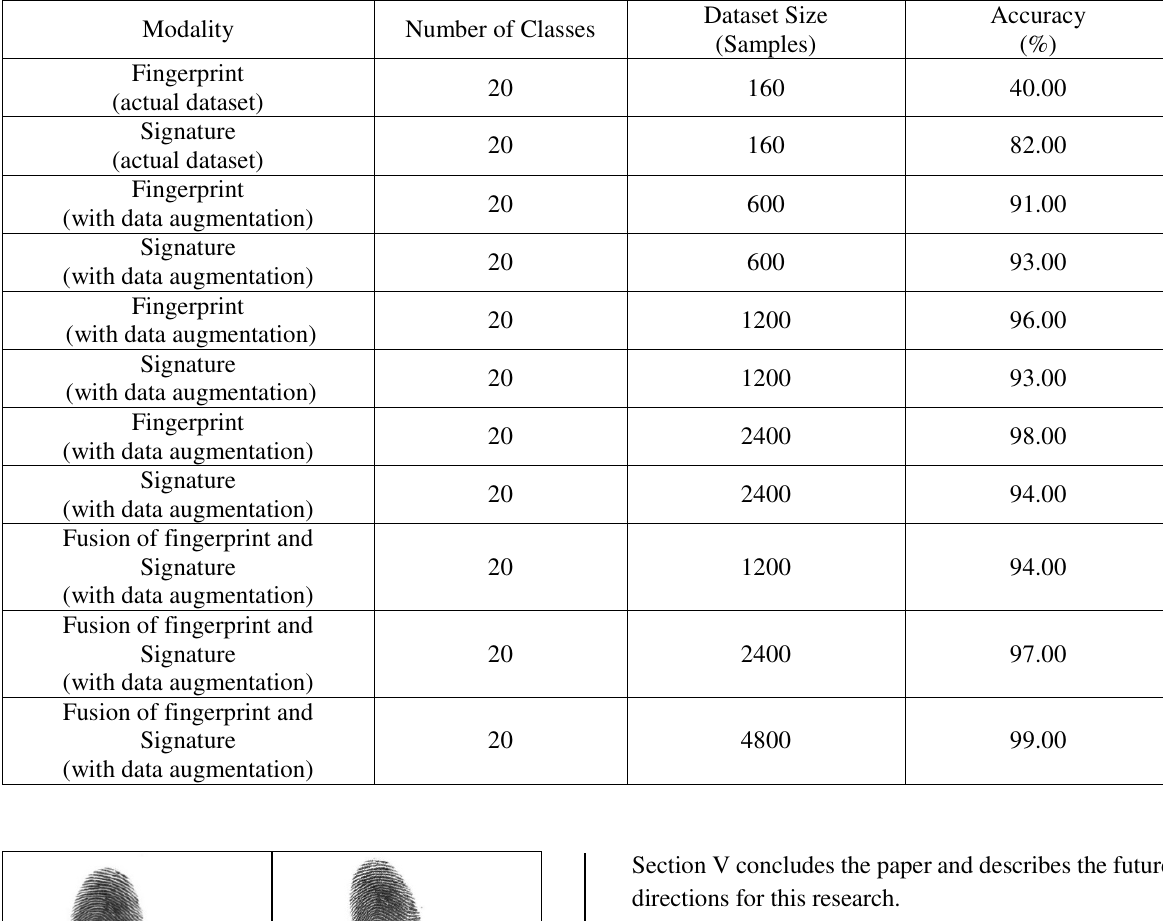
TABLE 1: ACCURACY RESULTS FOR RECOGNITION OF FINGERPRINT, SIGNATURE AND THE FEATURE-LEVEL FUSION OF FINGERPRINT WITH